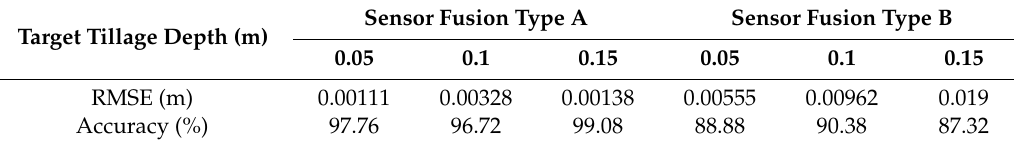
Figure 6. Soil non-penetration test of the real-time tillage depth measurement system. Table 3. Results of soil non-penetration test according to sensor fusion